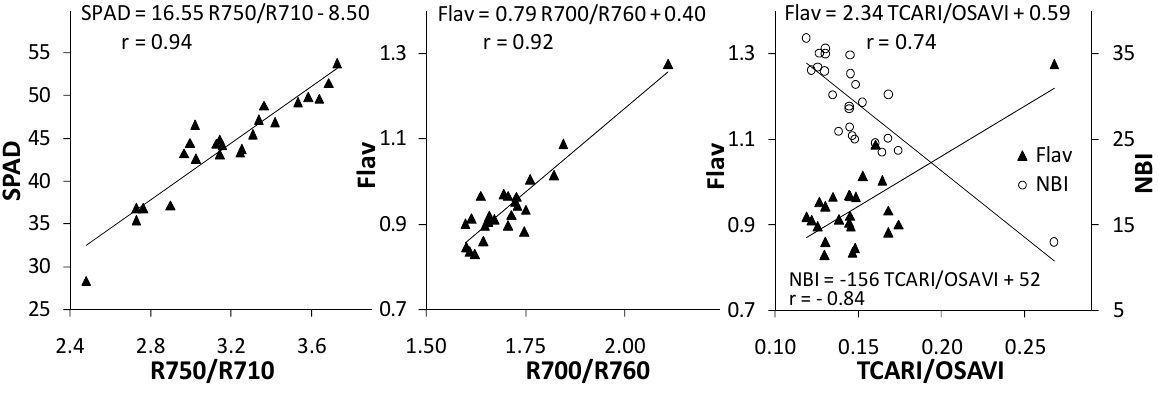
Figure 4. Linear correlations at flowering between selected airborne indices (R750/R710, R700/760 and TCARI/OSAVI ratios obtained from the high-resolution hyperspectral imagery) and ground-level indices (SPAD chlorophyll, flavonoids content (FLAV) and nitrogen balance index